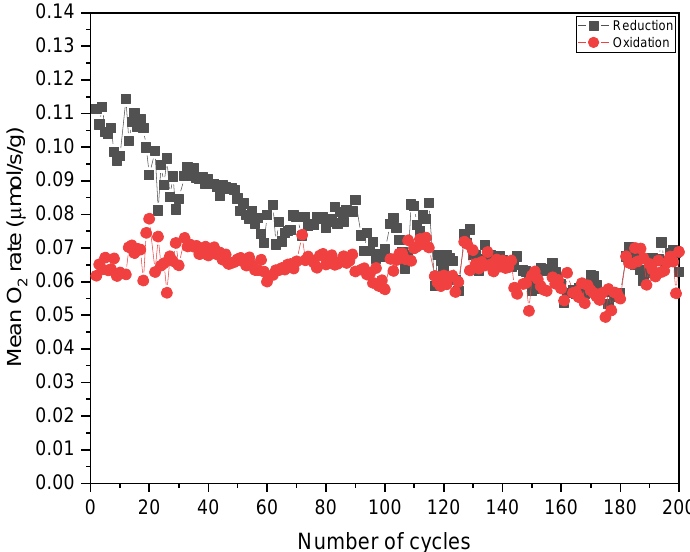
Figure 9. Mean reaction rates during reduction and oxidation per gram of ceria during the course of 200 temperature-swing cycles.